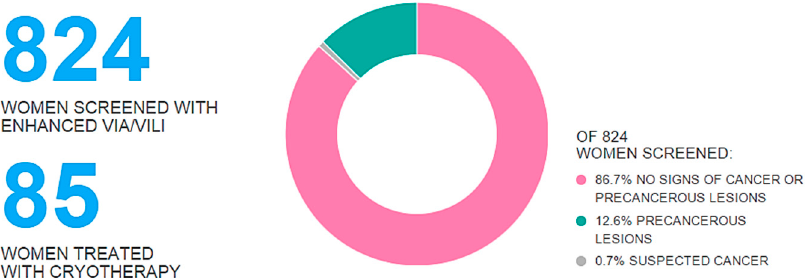
Figure 5. Aggregated screening and treatment data from the entire SCCA screening camp. The graphic is a screenshot from http://savelives.today/sccakenya2015.